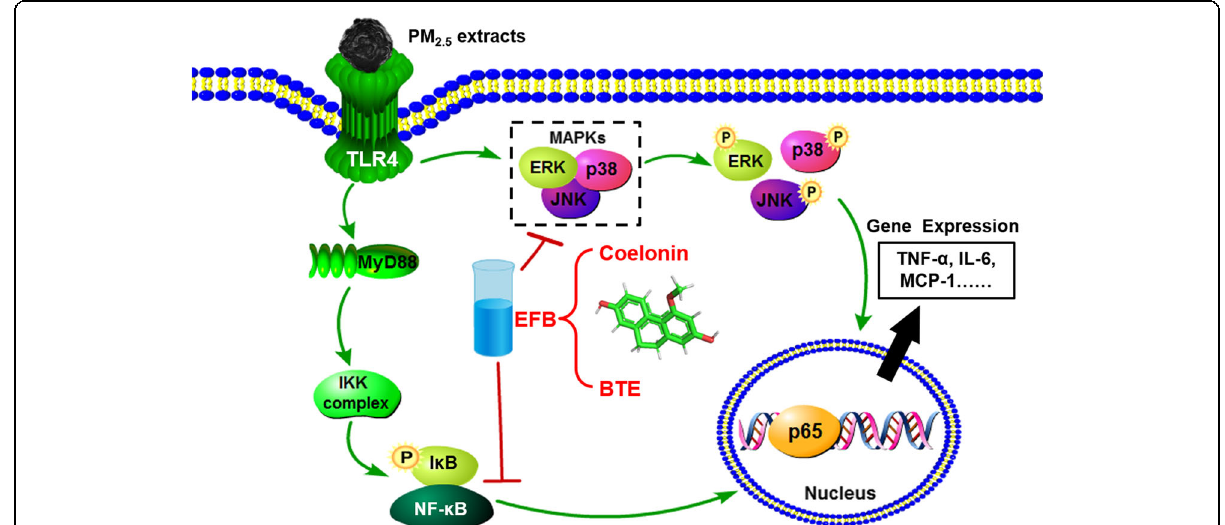
Fig. 10 Proposed mechanism of EFB in inhibiting PM 2.5 extracts activation of NF- κ B/MAPK signaling pathways in RAW264.7